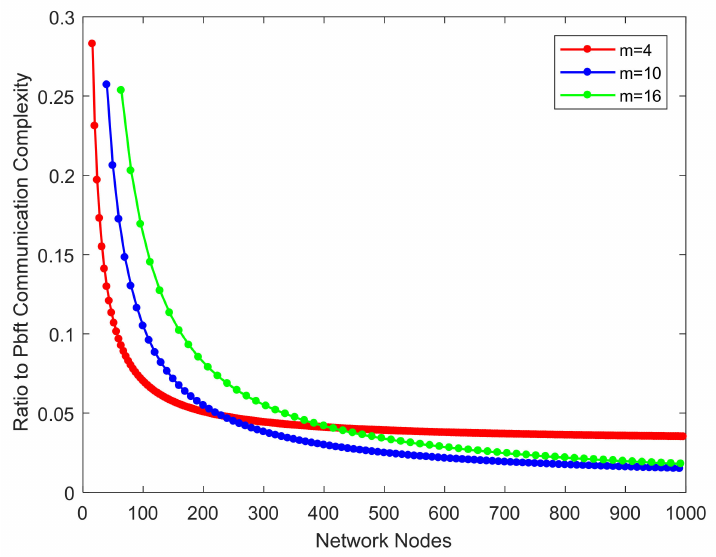
Figure 6. Ratio of the communication complexity of the TB-PBFT to the